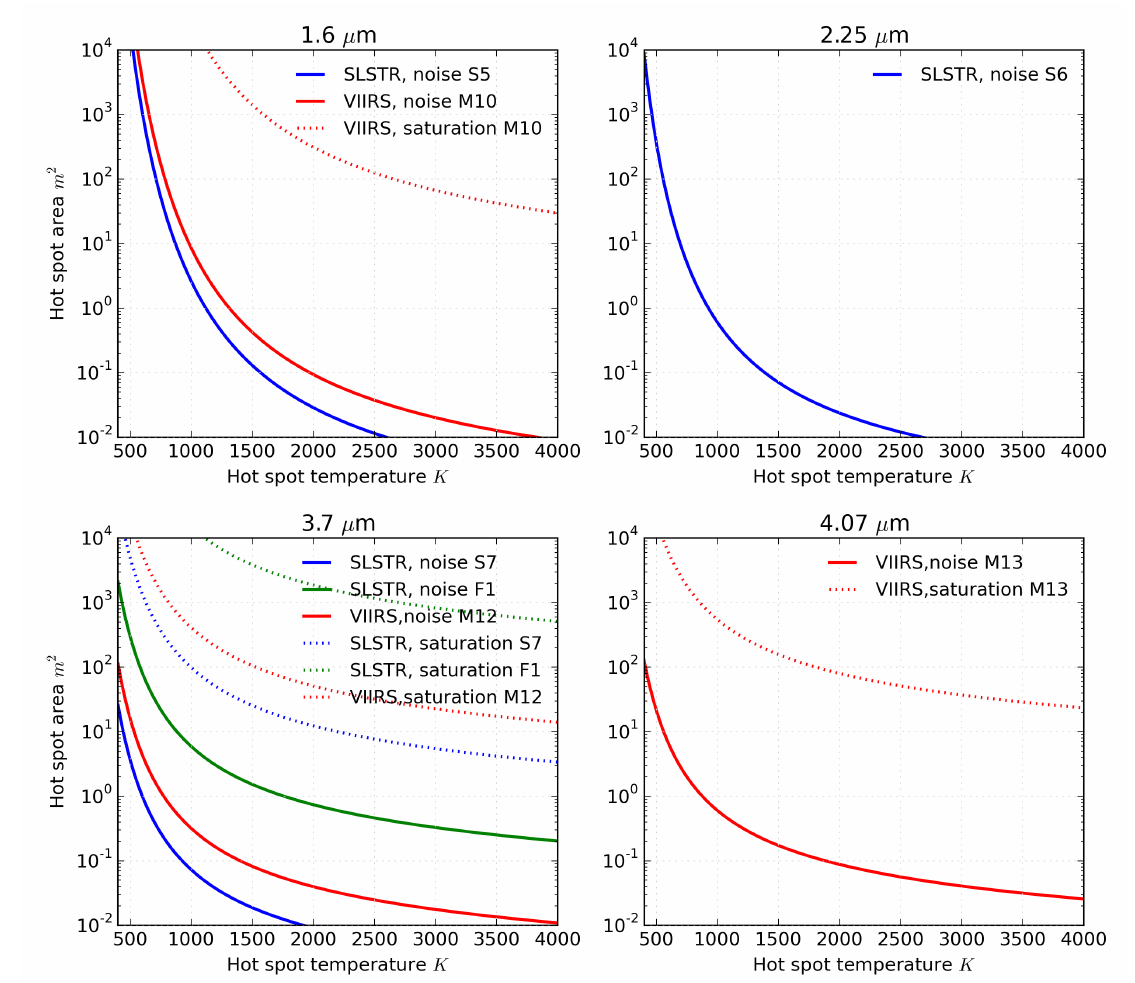
Figure 3. Isoradiance lines for the noise (SWIR bands S5 and S6 and MIR bands S7 and F1) and saturation levels (MIR bands S7 and F1) for SLSTR and noise and saturation for the SWIR and MIR bands (M10, M12 and M13) of VIIRS used in the Nightfire algorithm. The SLSTR noise levels were computed using the End-of-Life noise-equivalent differential reflectance (S5 and S6) and noise-equivalent differential temperature levels (S7 and F1) [47] and were 1.5 × 10 − 2 , 8.4 × 10 − 3 , 2.6 × 10 − 4 and 2.1 × 10 − 1 W m − 2 µ m − 1 sr − 1 for S5, S6, S7 and F1 respectively. A reflectance of